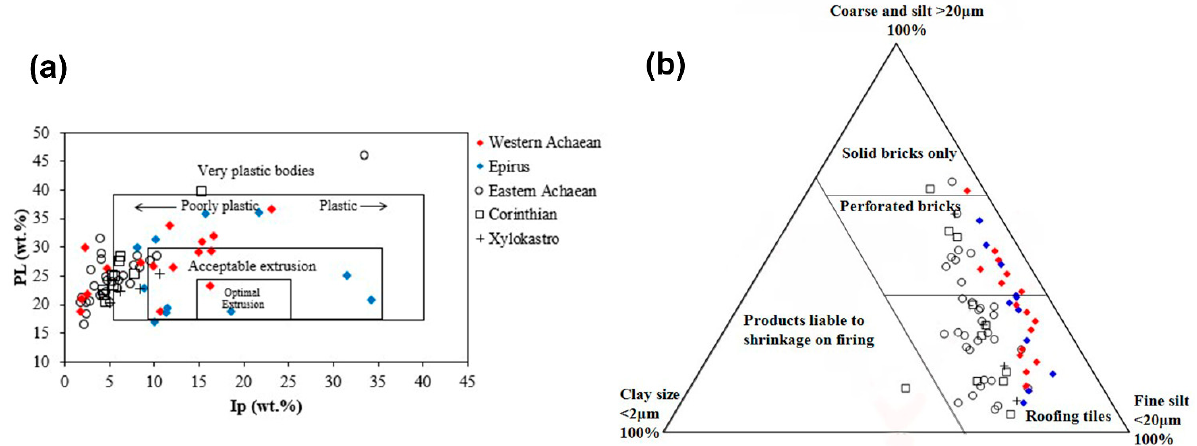
Figure 6. ( a ) Classification of molding behavior using plastic limits (PL) and plasticity index (Ip) values [35]. ( b ) Plot of the studied materials based on recommended grain sizes for the production of bricks and tiles [36]. The data for Eastern Achaean, Corinthia, and Xyloakastro are given elsewhere [12].